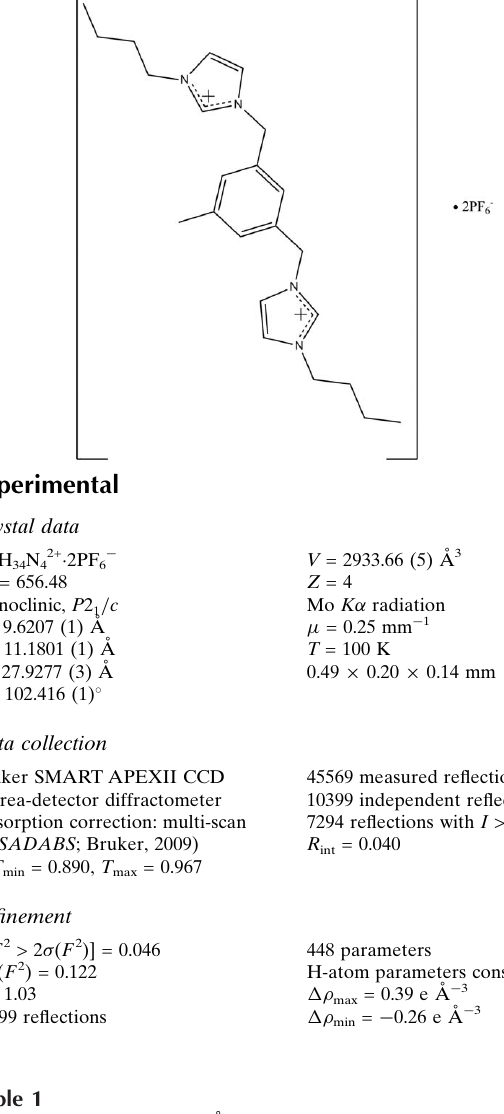
Hydrogen-bond geometry (A˚ , (cid:4) ). Cg 1 is the centroid of the C1–C6 phenyl